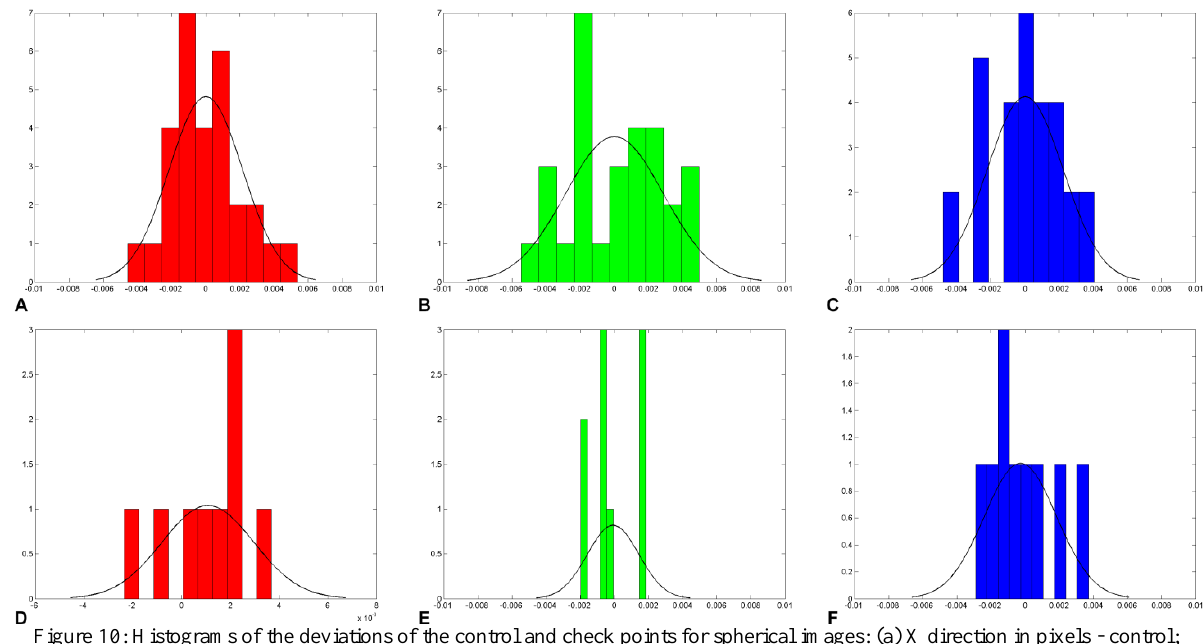
Figure 10: Histograms of the deviations of the control and check points for spherical images: (a) X direction in pixels - control; (b) Y direction in pixels -control; (c) Z direction in pixels - control; (d) X direction in pixels - check; (e) Y direction in pixels - check; (f) Z direction in pixels –